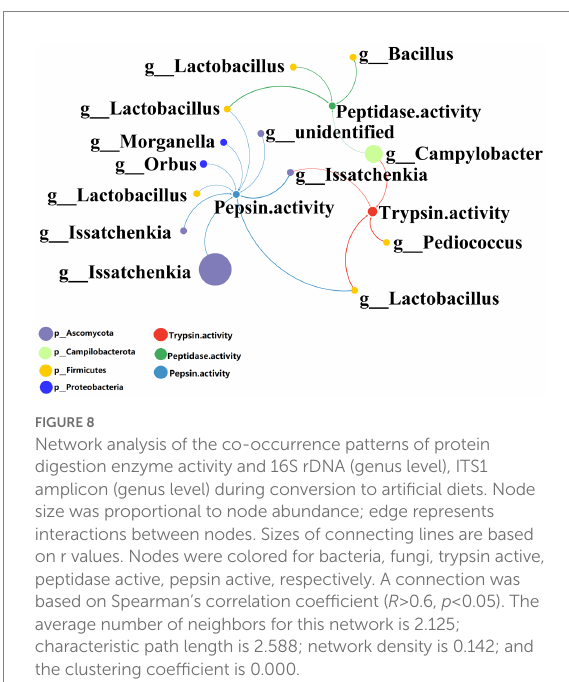
FIGURE 8 Network analysis of the co-occurrence patterns of protein digestion enzyme activity and 16S rDNA (genus level), ITS1 amplicon (genus level) during conversion to artificial diets. Node size was proportional to node abundance; edge represents interactions between nodes. Sizes of connecting lines are based on r values. Nodes were colored for bacteria, fungi, trypsin active, peptidase active, pepsin active, respectively. A connection was based on Spearman’s correlation coefficient ( R > 0.6, p < 0.05). The average number of neighbors for this network is 2.125; characteristic path length is 2.588; network density is 0.142; and the clustering coefficient is